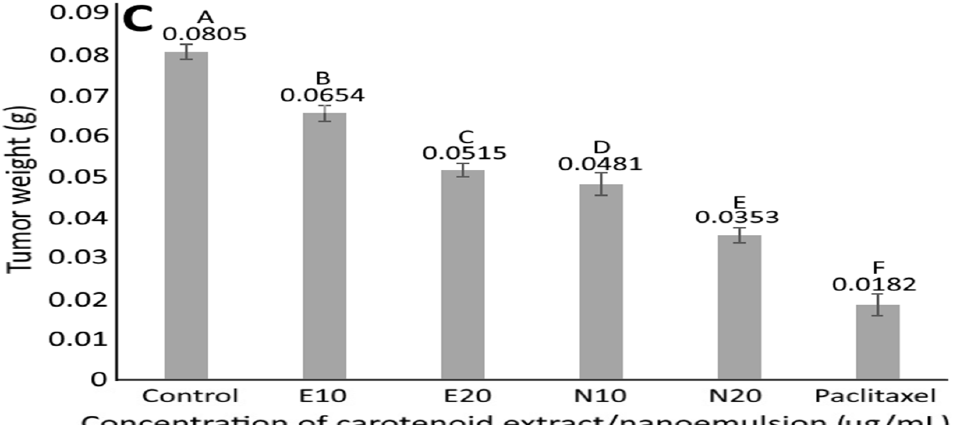
Figure 8. Effect of carotenoid extracts, carotenoid nanoemulsions and paclitaxel on tumor volume ( A ), tumor size ( B ) and tumor weight ( C ) of nude mice. E10 and E20, carotenoid extract concentration respectively at 10 and 20 µ g/mL; N10 and N20, carotenoid nanoemulsion concentration respectively at 10 and 20 μ g/mL; Paclitaxel, paclitaxel concentration at 10 μ g/mL. Results are presented as mean ± standard deviation of measurements from six nude mice ( n = 6). Data with different capital letters (A–F) are significantly different at p < 0.05.